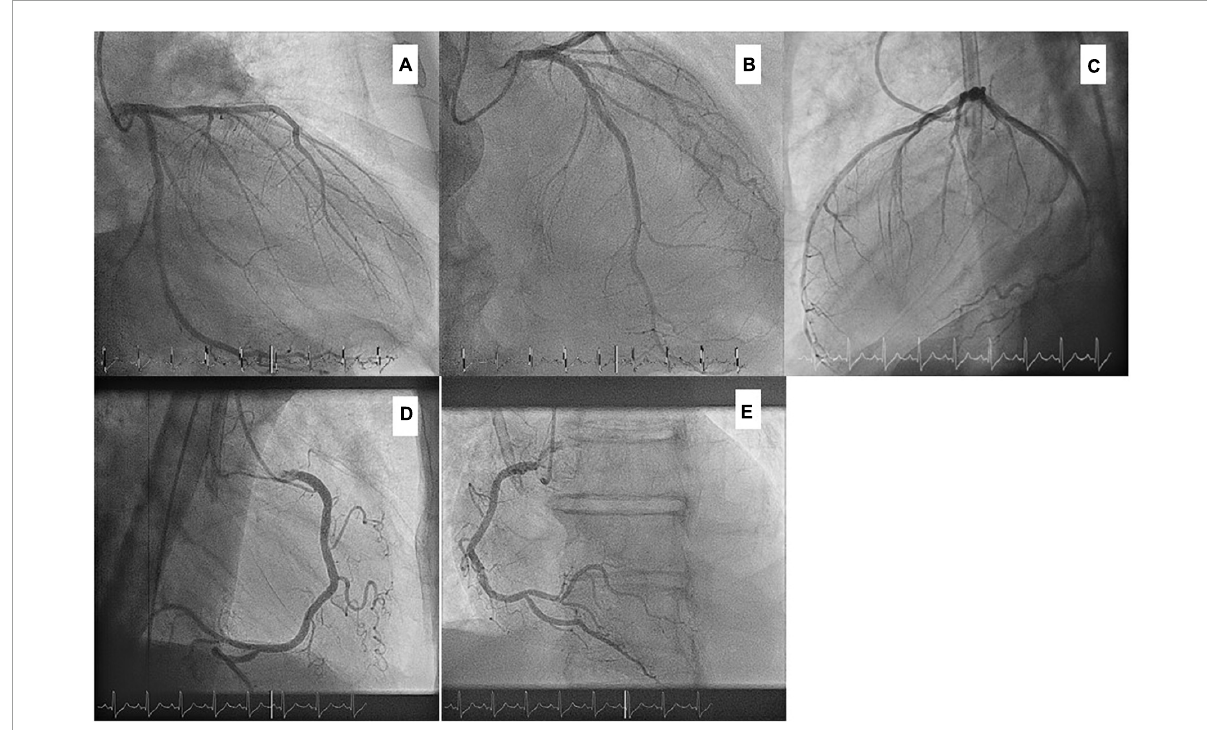
FIGURE3 Coronary angiography without significant obstructive coronary artery disease. (A) cranial, 40 ◦ (B) RAO, 20 ◦ ; caudal, 30 ◦ (C) LAO, 90 ◦ (D) RAO, 90 ◦ (E) LAO, 30 ◦